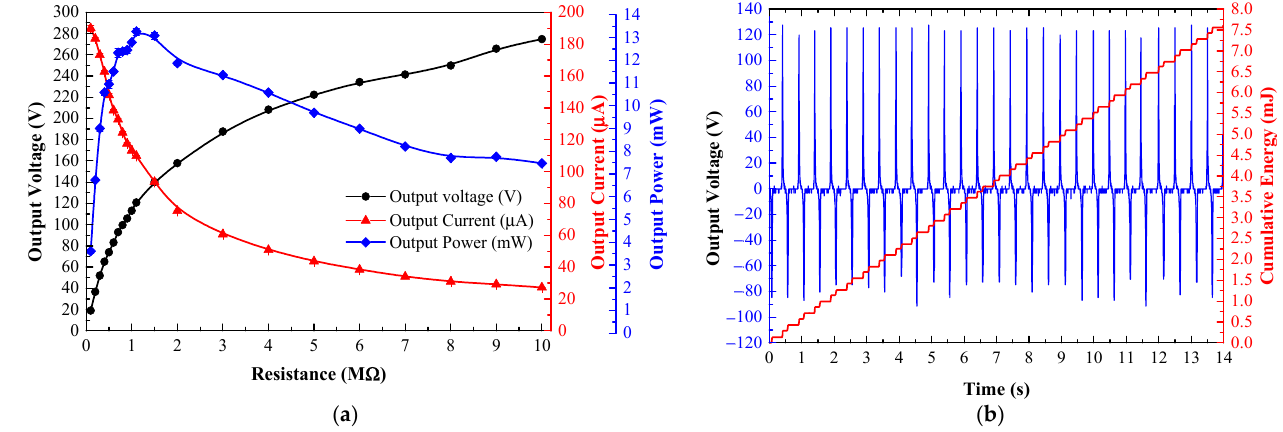
Figure 10. Electrical characteristics of TEHFT with the 0.2 mm PTFE film thickness: ( a ) output voltage, current, and power across resistive loads; and ( b ) graph of output voltage and accumulated energy across the optimal load.